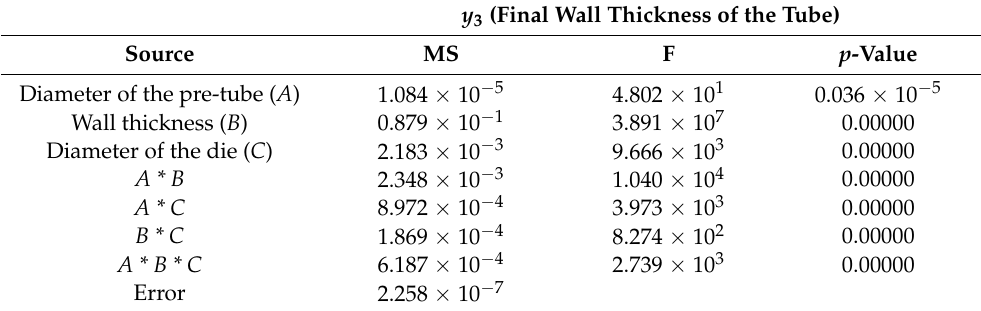
Table 12. Summary of key ANOVA values for the response variable y 3